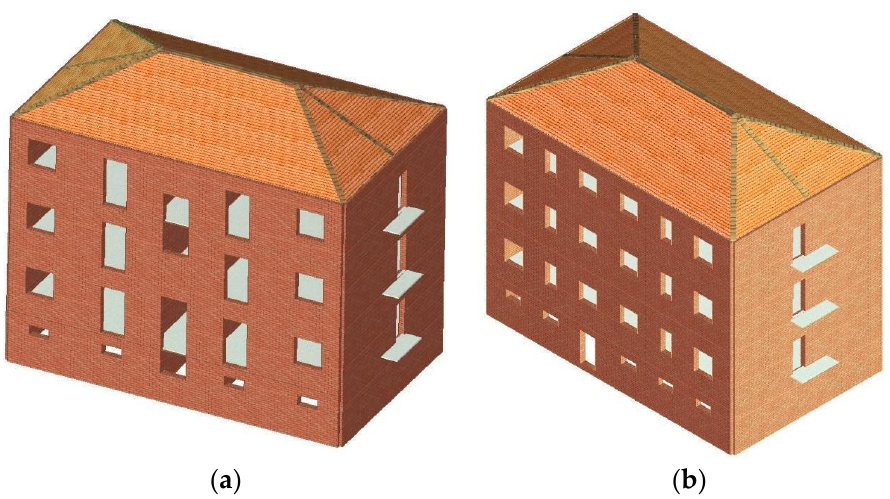
Figure 9. 3D views of the TreMuri 3D model of the building: ( a ) Front view and ( b ) back view.